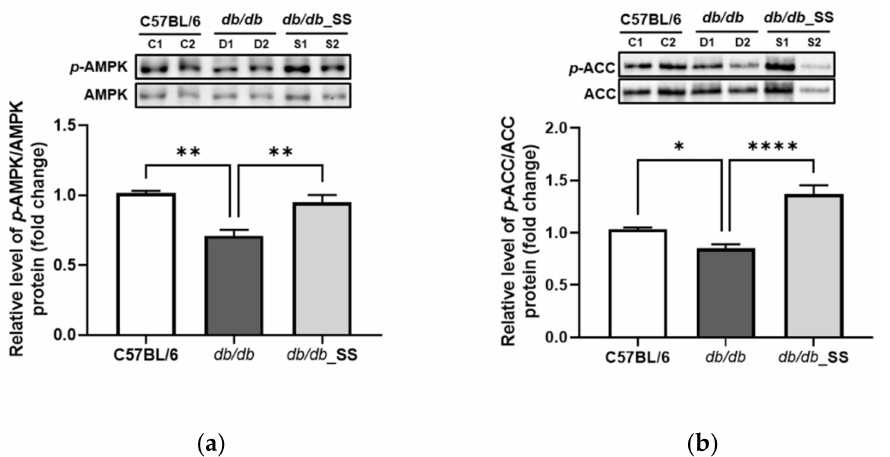
Figure 8. The effect of stevioside on the expression of ( a ) adenosine monophosphate-activated protein kinase (AMPK) and ( b ) acetyl-CoA carboxylase (ACC) in mouse epididymal adipose tissue of C57BL/6 mice and db/db mice. C57BL/6 (C1 and C2); negative control group that received saline, db/db (D1 and D2); control group that received saline, db/db _SS (S1 and S2); control group that received 40 mg/kg of stevioside. data are presented as mean ± SD, and tests were performed in three